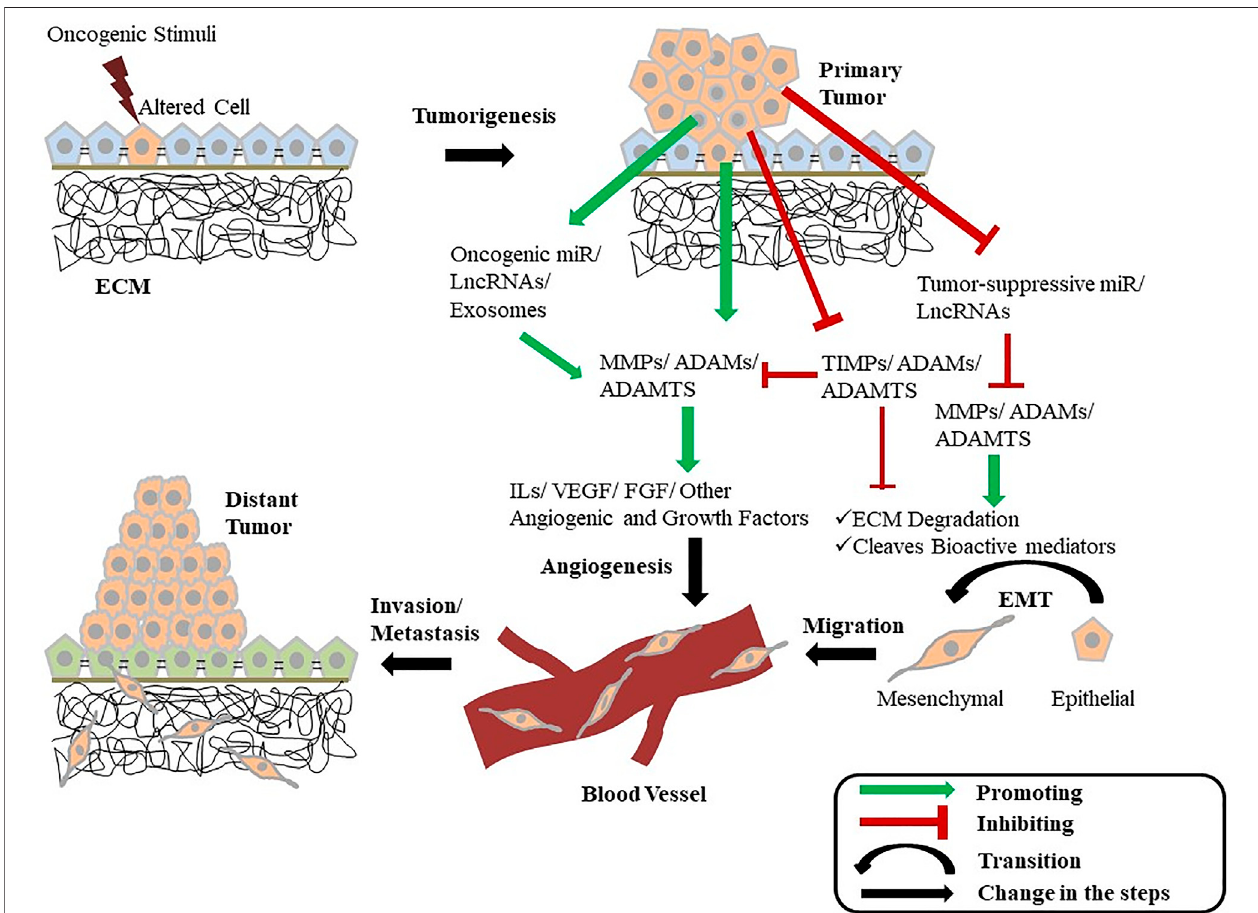
FIGURE 2 | Diagrammatic illustration showing the intertwined relationship of metalloproteinases with cancer. A normal cell gets altered and becomes tumorigenic when gets exposed to an oncogenic stimulus. These tumorous cells can now enhance the activity of multiple growth-promoting MMPs, ADAMs, and ADAMTS while inhibiting the function of their inhibitors (TIMPs) and growth-inhibiting metalloproteinases. The tumor cells also promote the expression of certain miRNAs and LncRNAs that increases the expression of MMPs, ADAMs, and ADAMTS as well as inhibit the expression of tumor-suppressing miRNAs and LncRNAs. These cells also releaseexosomescontainingvariousMMPsandADAMs.ThesecretedmetalloproteinasespromoteECMdegradationandalsocleavevariousotherbioactivemediators promotingEMTandtumorprogression.Metalloproteinasesfurtherin fl uencethereleaseofvariouscytokines,angiogenicfactors,andothergrowthfactors,leadingtothe activation of angiogenesis and other cellular pathways associated with tumor growth. This EMT and angiogenesis mediated by the MMPs and ADAMs provide the cell the ability to invade and metastasize in distant tissues. ECM, Extra-Cellular matrix; MMP, Matrix metalloproteinase; ADAM, A Disintegrin and metalloproteinase; ADAMTS, A Disintegrin and metalloproteinase with Thrombospondin Motif; TIMP, Tissue Inhibitors of metalloproteinase; miR, MicroRNA; LncRNA, Long Non-Coding RNA; IL, Interleukin; VEGF, Vascular Endothelial Growth Factor; FGF, Fibroblast Growth Factor; EMT, Epithelial-to-Mesenchymal Transition.